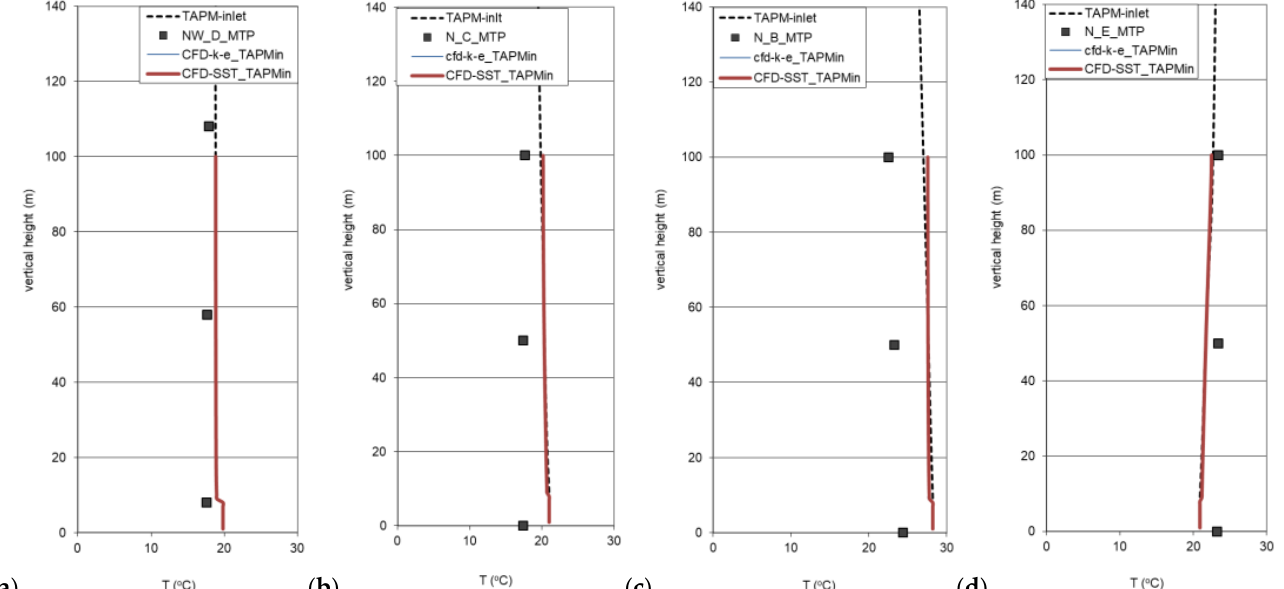
Figure 6. Vertical profiles of wind turbulence kinetic energy over position 2 (Figure 1), corresponding to four stability conditions ( a ) D, ( b ) C, ( c ) B, ( d ) E (Table 1). Comparison of CFD results using two different turbulence models (k- ε and SST). M esoscale results (“TAPM - inlet”) are also shown.